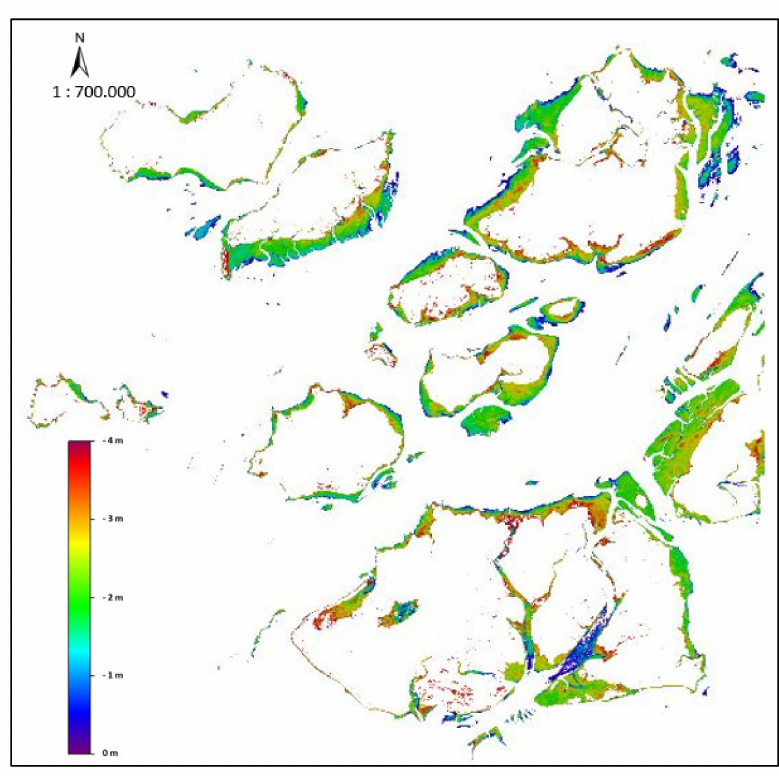
Figure A3. Bathymetric model for the Bijag ó s archipelago achieved through the logarithm ratio band algorithm. S2A L2A 06DEC2017